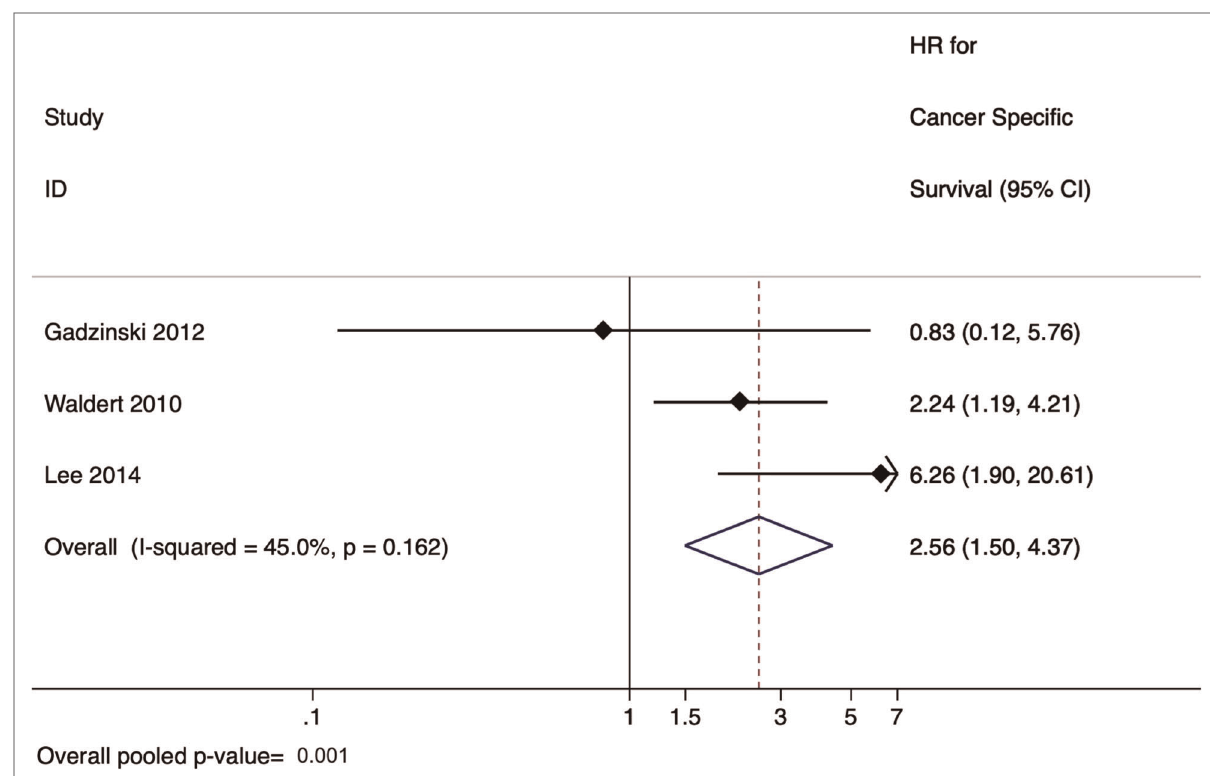
FIGURE 4 Forrest plot for meta-analysis on effect of delayed radical nephro-ureterectomy on cancer-speci fi c survival in upper tract urothelial